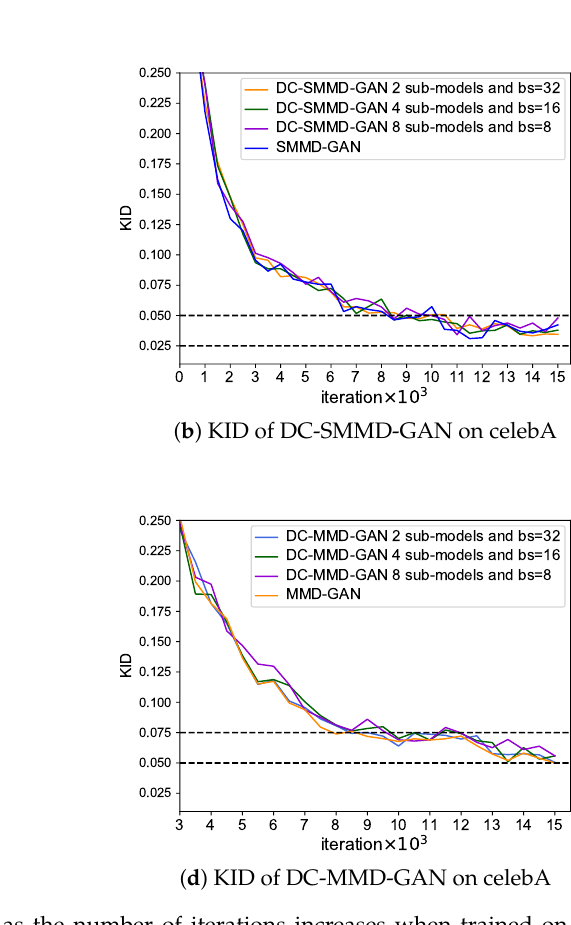
Figure 8. The evolution of FID and KID as the number of iterations increases when trained on celebA. Compared to the score of MMD-GANs with batch size equaling to cm, DC-MMD-GANs reach competitive score with less training time. Table 1. Training time of different models on CelebA and